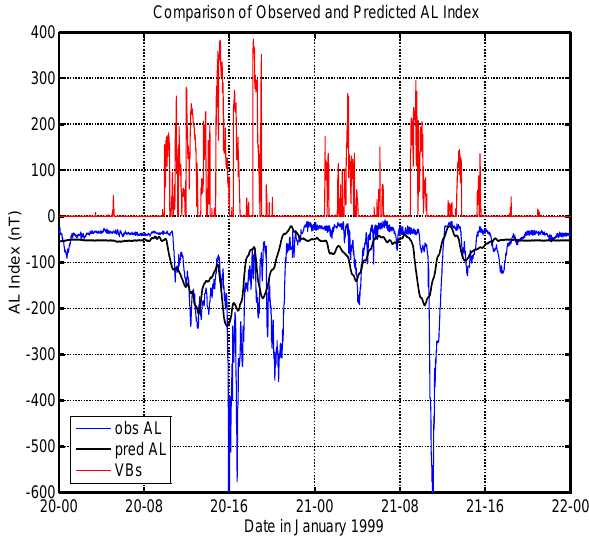
Figure 2. An illustration of the relation between time series of solar wind electric field (VBs) and the AL index for two days in January 1999 is presented. Top trace (red) is the rectified electric field. The bottom trace denoted by a thin blue line is the observed AL index for the same two days. The thicker black line is the output of a linear filter representing the relation between these quantities.